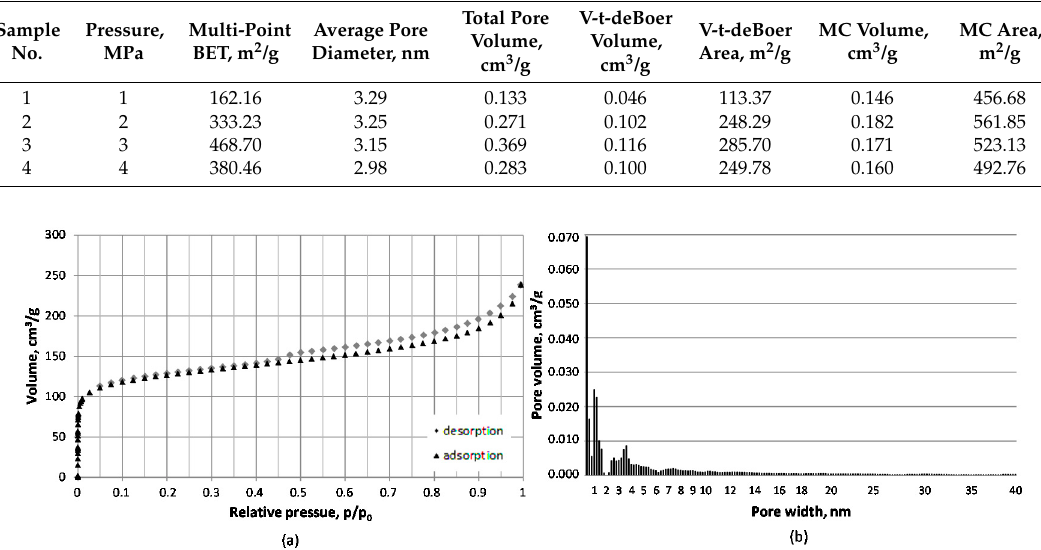
Table 2. Parameters of the porous structure of carbon materials determined on the basis of nitrogen sorption isotherm at − 196 °C and carbon dioxide sorption isotherm at 0 °C. Sample No.